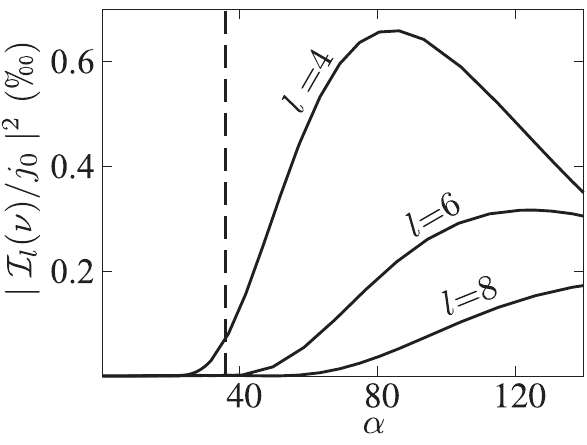
Figure 4: High-order even harmonics as a function of the parameter α . The asymmetry parameter is δ (cid:2) 1 . 2 and the frequency of the oscillating fi eldis v =141GHz.Thedashedcurvesigni fi esthecritical value α c for which the SSL can operate in the NDC part of the VI